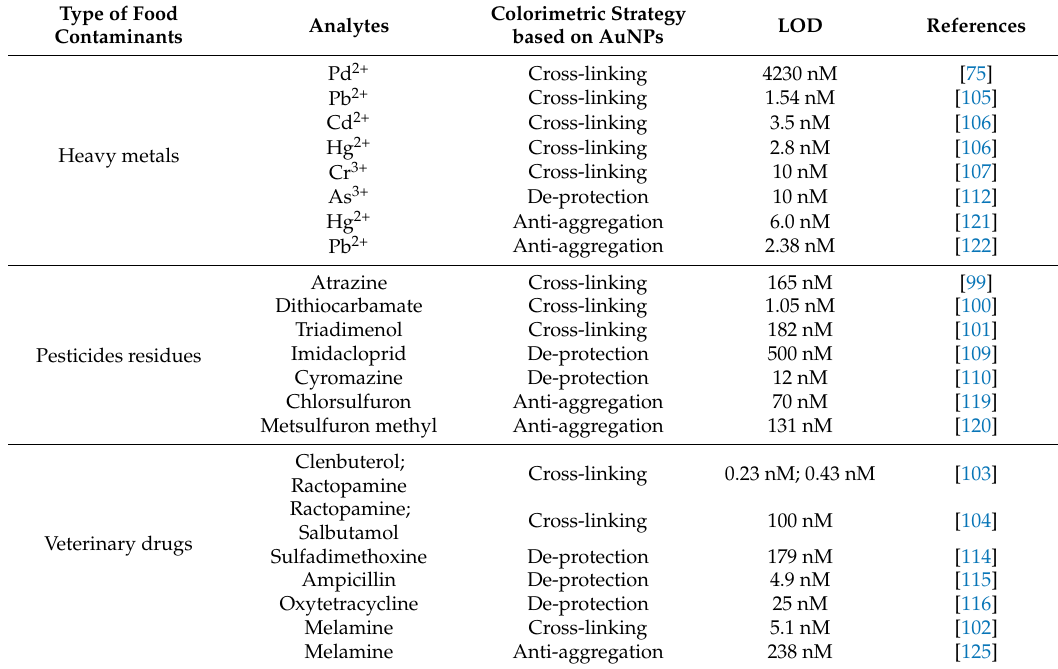
Table 1. Applications of colorimetric strategy based on AuNPs for food contaminants